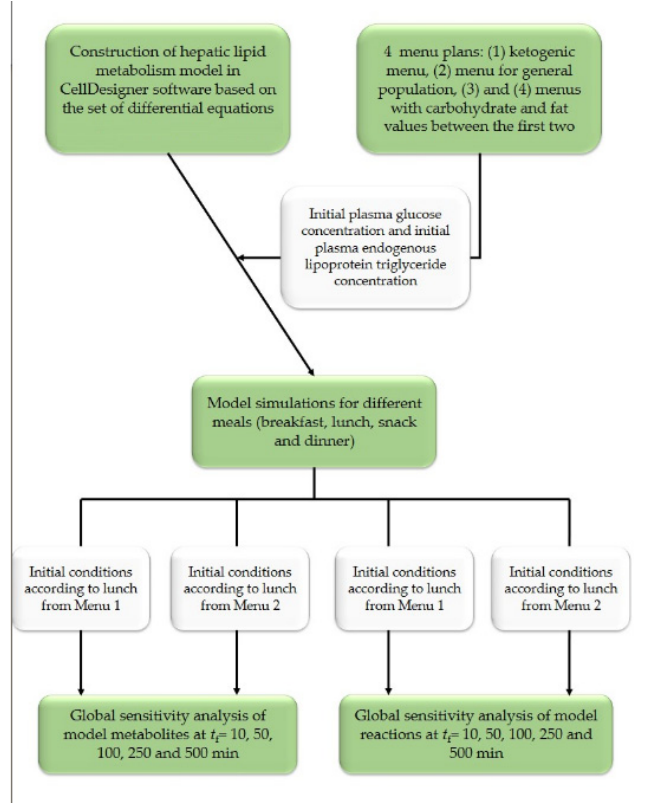
Figure 1. Research flowchart. Construction of hepatic lipid metabolism model in CellDe- signer software based on the set of differential equations proposed by Pratt et al. [35].